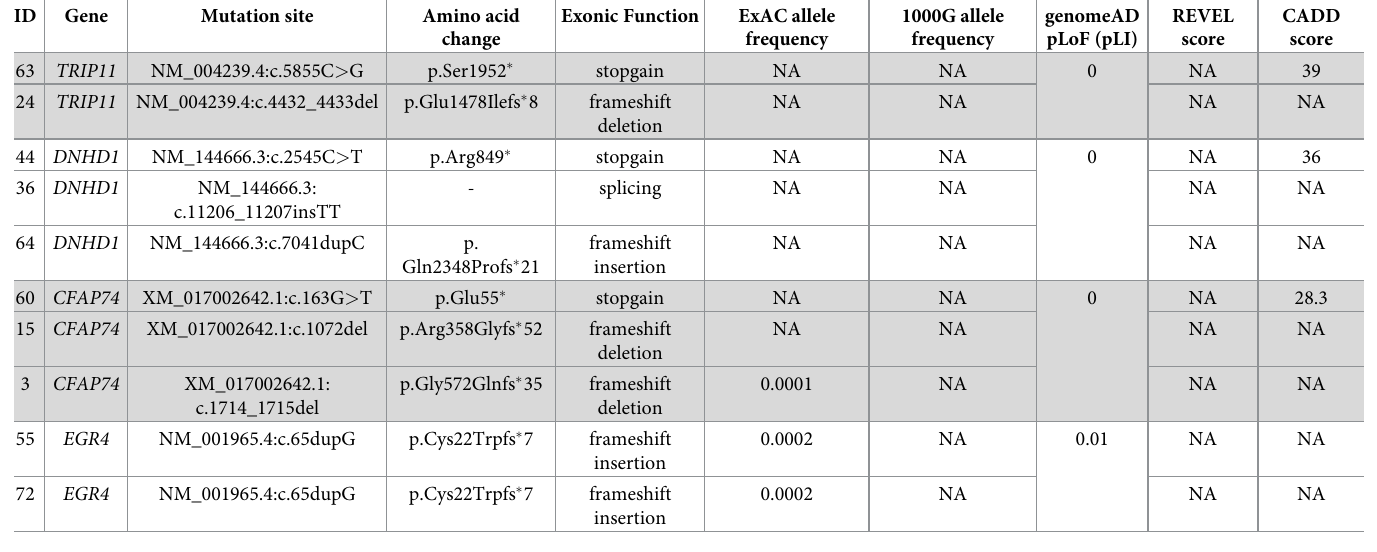
Three types of heart tube morphologies occur in zebrafish embryos: normal dextral-loop (D-loop), reversed sinistral loop (s-loop), and no loop (Fig 3A). All MOs were injected at the one-cell stage, and embryos were raised until 48 hpf, at which time the cardiac looping mor- phology was assessed. We found that three of the four candidate gene MOs exhibited a robust Table 3. The bioinformatics information on the LOF variants of candidate genes and patients. ID